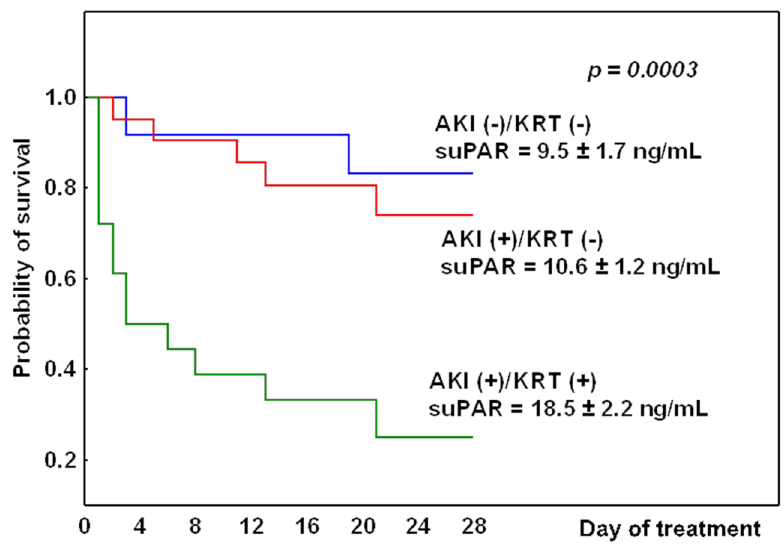
Figure 2. Comparison of 28-day survival in the three studied groups ( p = 0.0003) based on the AKI diagnosis and the requirement for KRT on admission to the ICU.